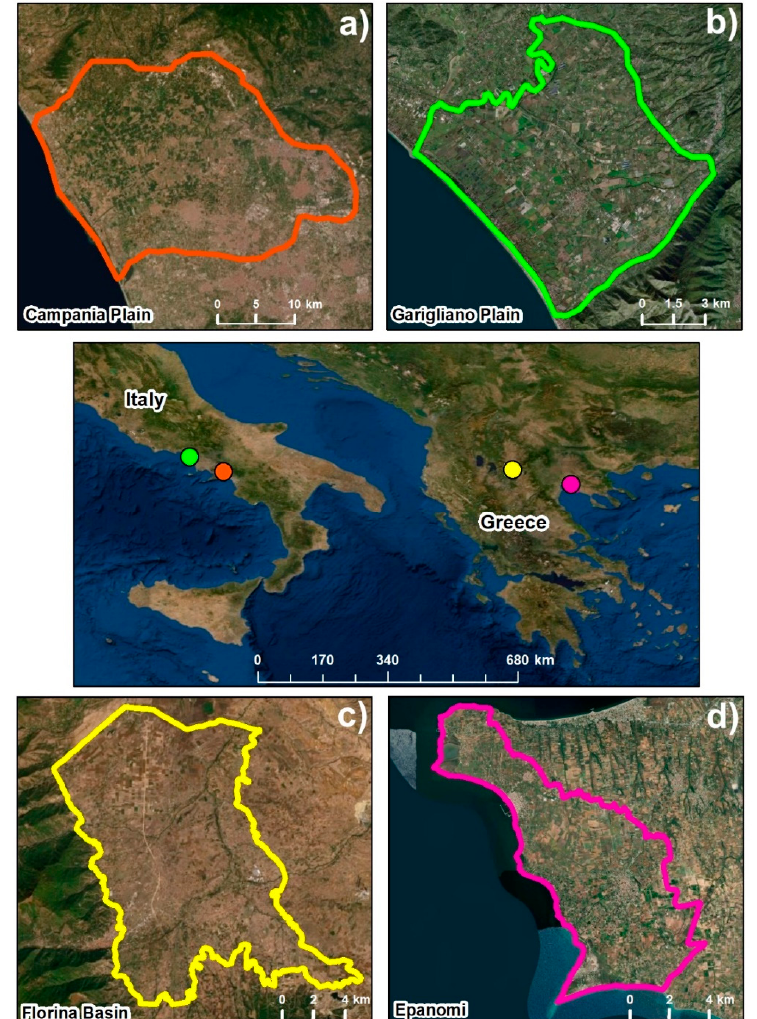
Figure 1. Study areas: a) Campania plain, b) Garigliano River plain, c) Florina basin, d) Epanomi.